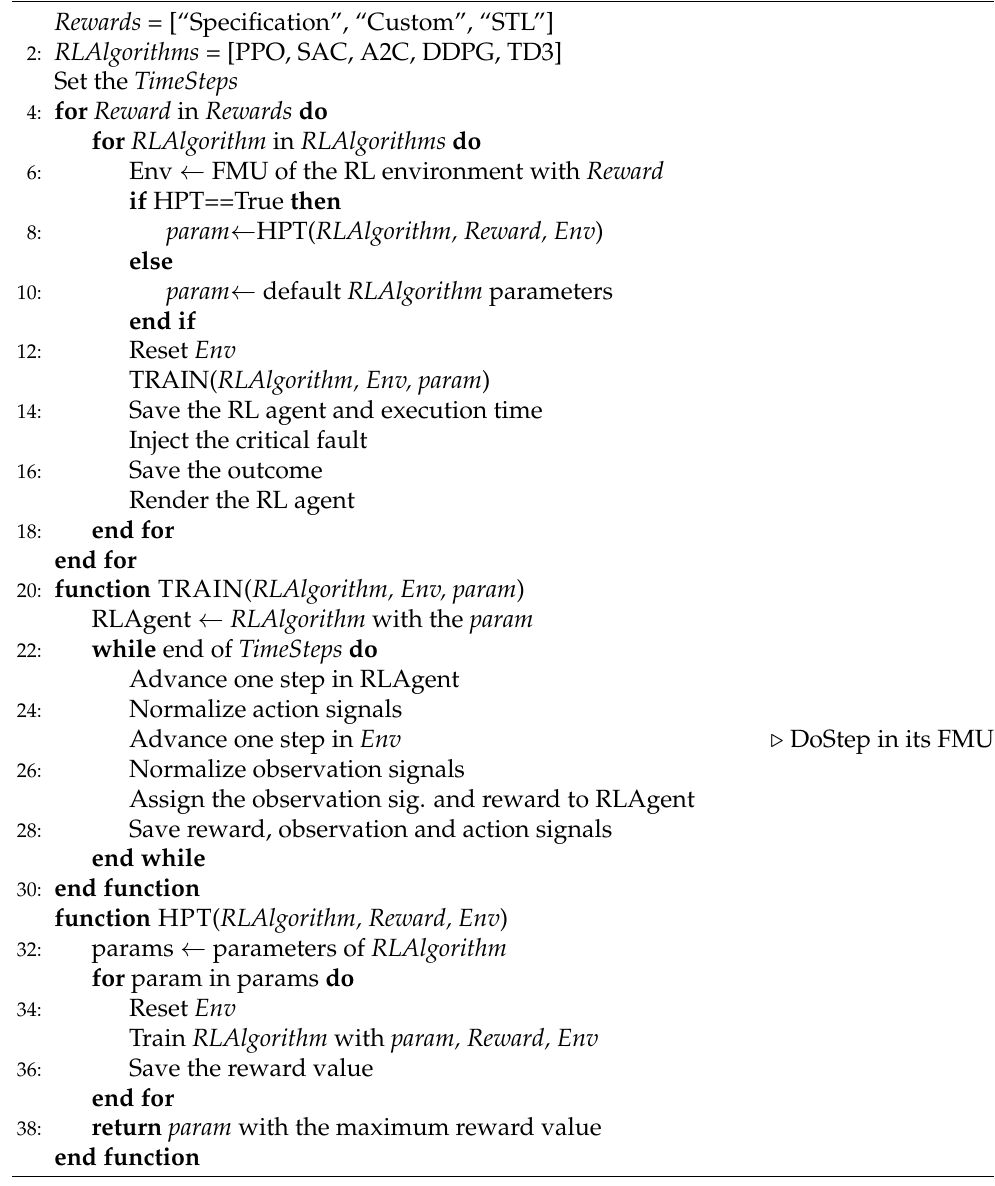
Algorithm 1 Algorithm of the proposed